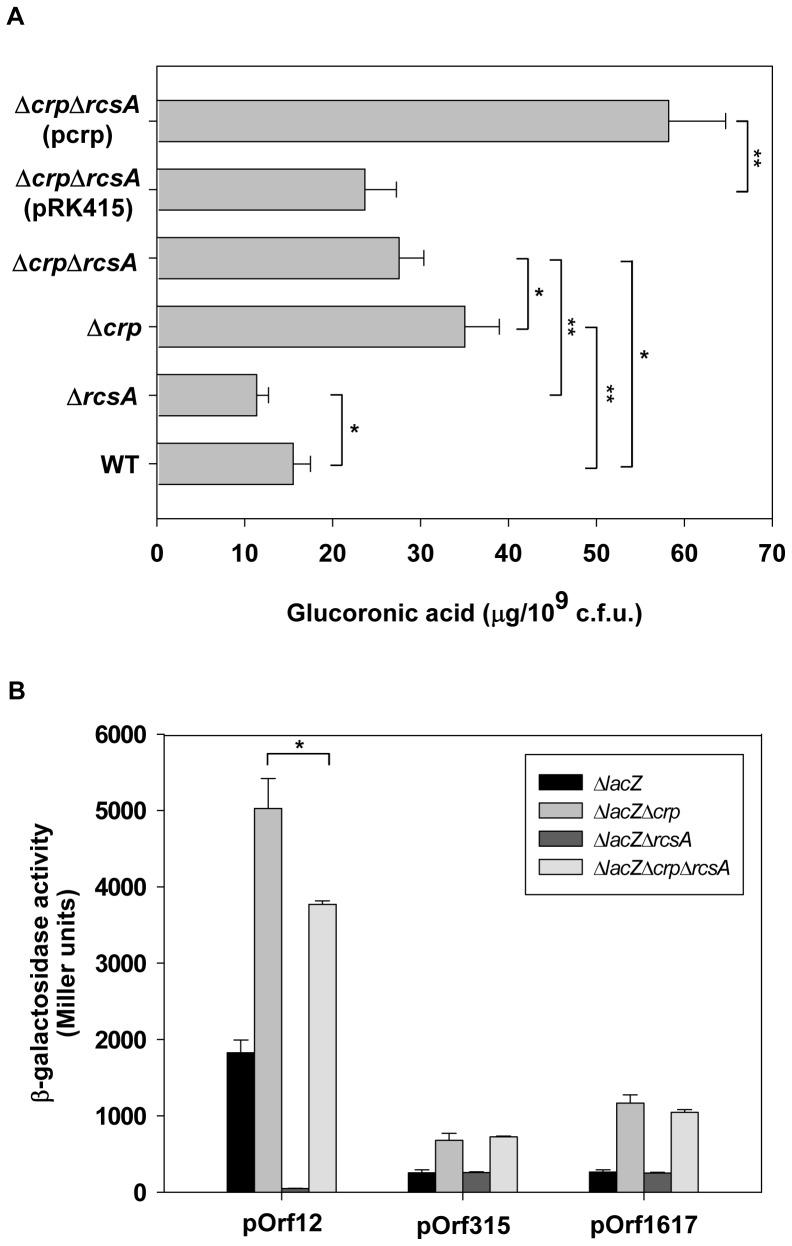
RcsA is involved in CRP regulation of CPS expression.(A) CPS levels of WT, ΔrcsA, Δcrp, and ΔcrpΔrcsA strains were determined. For complementation purposes, introduction of pRK415 and prcsA into ΔcrpΔrcsA strain were also determined. Bacterial strains were grown in LB broth as indicated at 37°C with agitation. After 16 h of growth, the bacterial glucuronic acid content was determined. *P<0.05 and **P<0.01 compared to the indicated group. (B) The β-galactosidase activities of K. pneumoniae CG43S3ΔlacZ and the isogenic strains (ΔlacZΔcrp, ΔlacZΔrcsA, and ΔlacZΔcrpΔrcsA) carrying the reporter plasmid pOrf12 (Porf1-2::lacZ), pOrf315 (Porf3-15::lacZ), or pOrf1617 (Porf16-17::lacZ) were determined using log-phased cultures grown in LB medium. The results shown are an average from triplicate measurements in one single experiment representative of three independent experiments. Error bars indicate standard deviations. *P<0.05 compared to the indicated group.